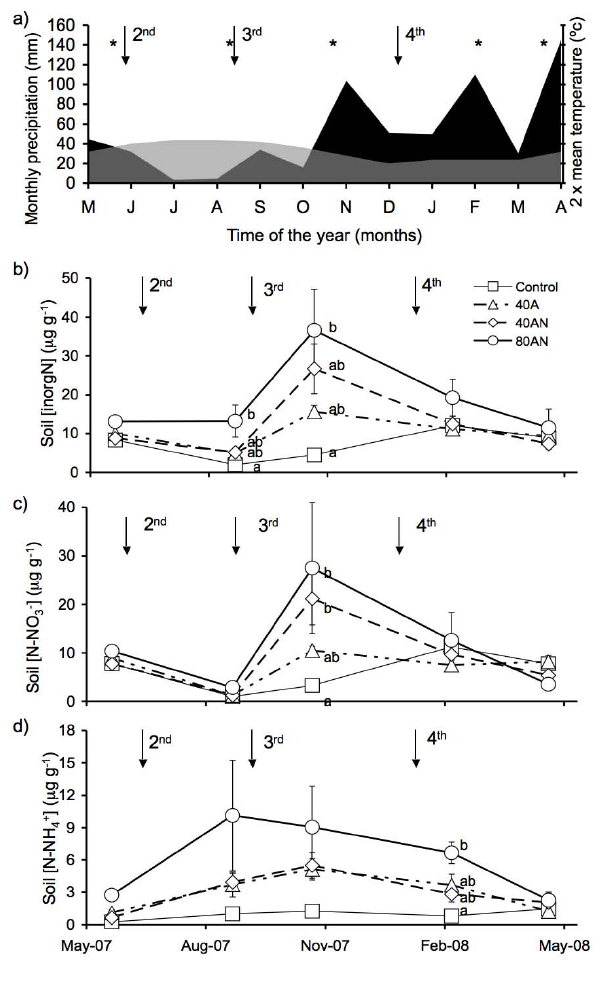
Fig. 1. Mean monthly temperature (grey), total monthly precipi- tation (black) and time of N additions (arrows) and soil sampling (asterisks) from May 2007 to May 2008 (a) . Soil inorganic N (b) , nitrate (c) and ammonium (d) concentrations according to the distinct N additions (Control, 40A, 40AN, and 80AN). Different letters refer to statistically significant differences between the be- tween treatments (ANOVA p < 0.05 followed by a Bonferroni test). There were no significant interactions between treatment and time ( p < 0.01). Values represent the mean ( n =3 experimental plots per treatment) ± SE.